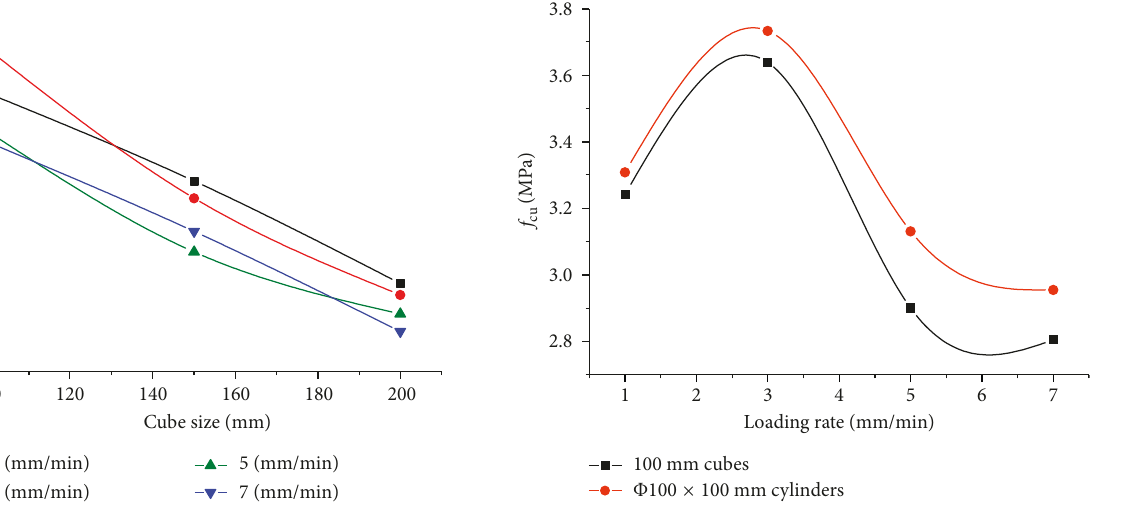
Figure 2: Compression strengths of differently sized cubes. Figure 3: Compression strengths of 100mmcubes to Φ 100 × 100mm cylinders.